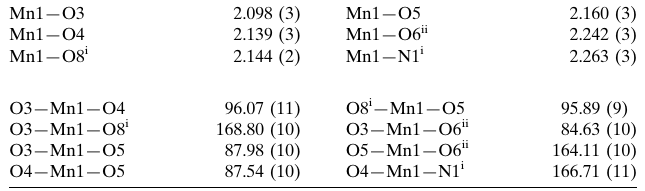
Selected geometric parameters (A˚ , (cid:2) ).